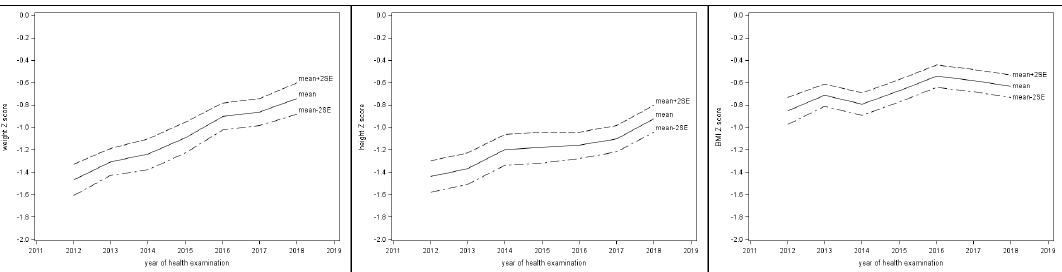
Figure 2. Z -score trends of BW, BH, and BMI from 2012 to 2018 superimposed on the WHO standards (BW: body weight, BH: body height, BMI: body mass index).